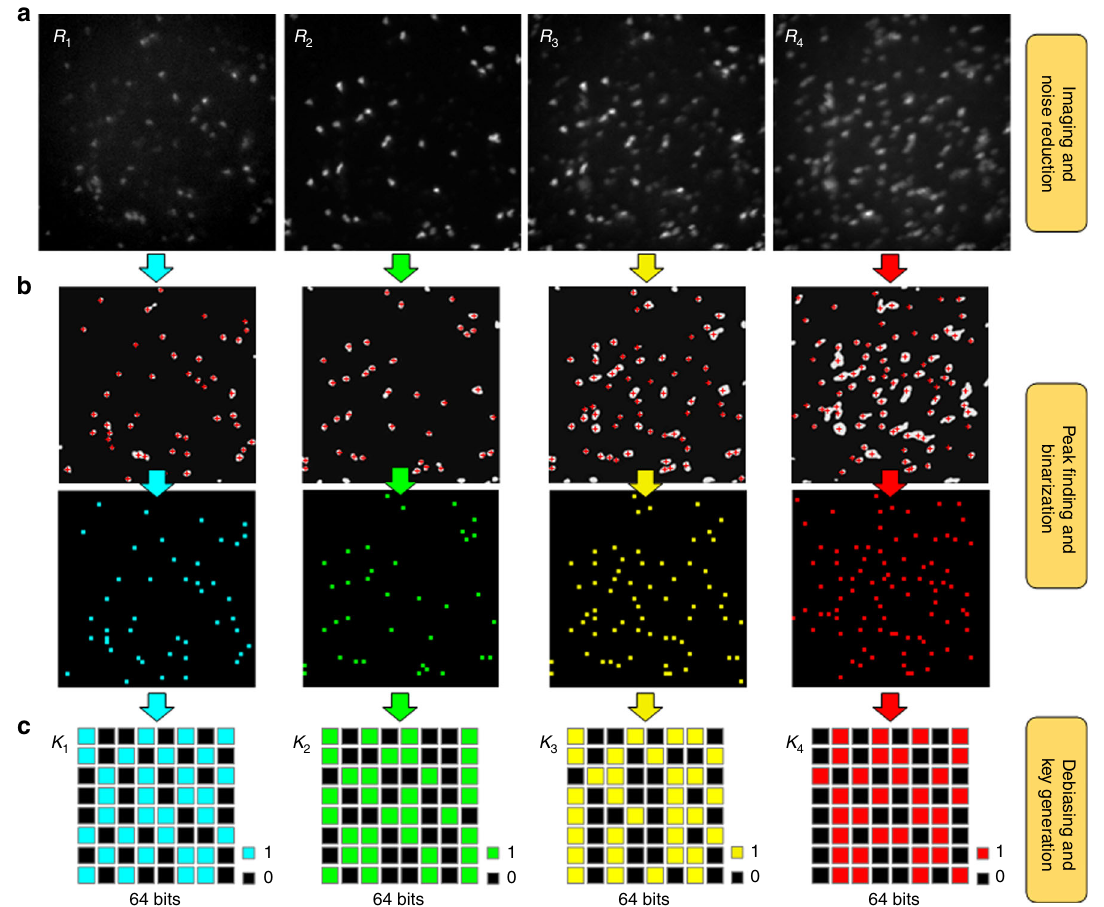
Fig. 4 Basic elements in the extractor. a The reading apparatus acquires raw fl uorescent images of responses ( R n ) of an edible PUF device in which an admixture of eCFP, eGFP, eYFP, and mKate2 silk microparticles is embedded in a thin silk fi lm (300 pixels × 300 pixels). b The peak fi nding and binarization processes provide high stability and reproducibility in key generation, reducing the number of pixels to 50 pixels × 50 pixels. c The von Neumann debiasing process allows to compress dominant 0-bits resulting from the relatively small number of peaks. In simple von Neumann debiasing, the rate of compression is too high such that the raw data size needs to be much larger than an extracted size. In our extractor, the two-pass tuple-output von Neumann debiasing algorithm maintains a practical data size. After von Neumann debiasing, fi rst 64 bits in each digitized key ( K n ) are selected to create a total of 256-bit security